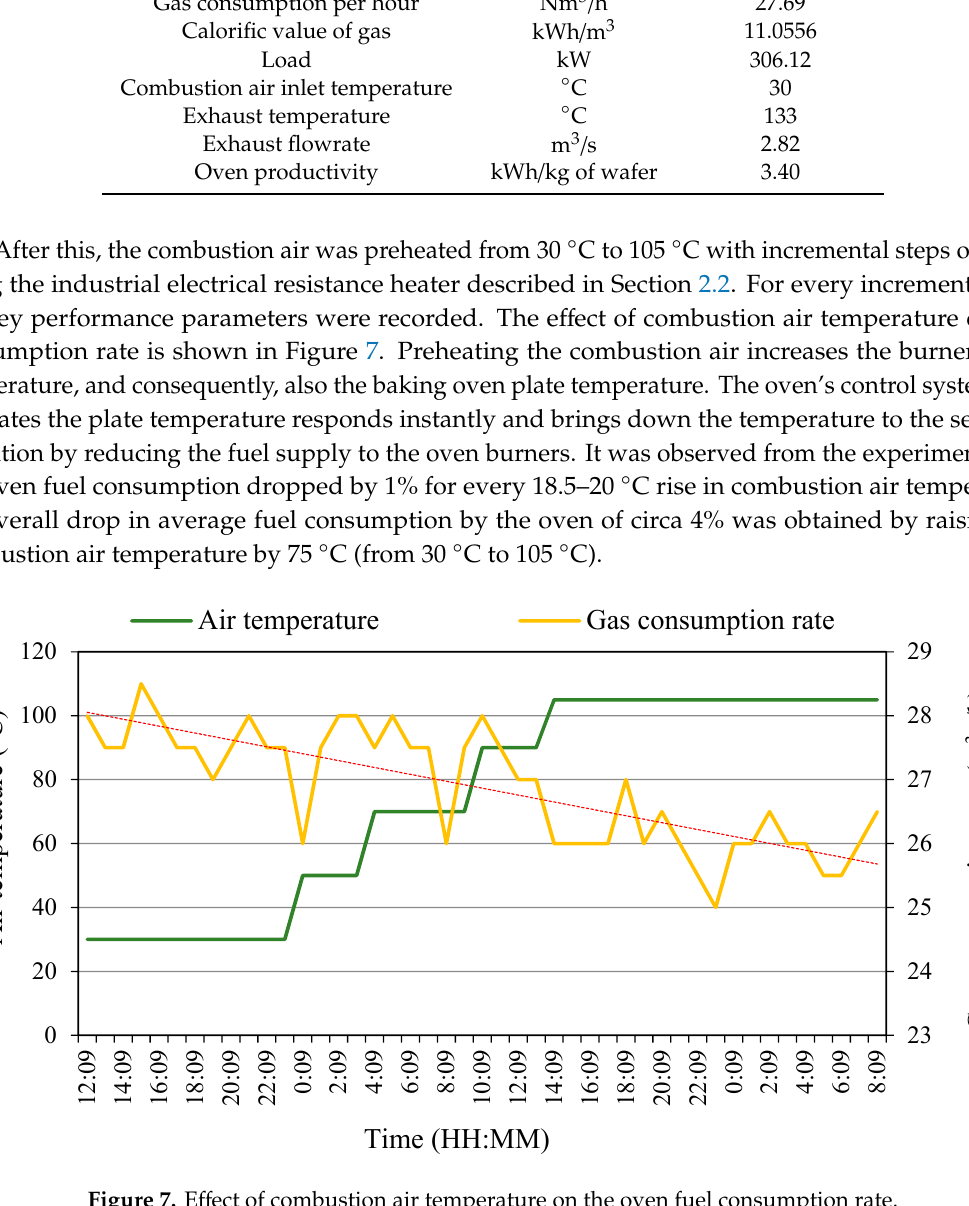
Figure 7. E ff ect of combustion air temperature on the oven fuel consumption Figure 7. Effect of combustion air temperature on the oven fuel consumption rate.